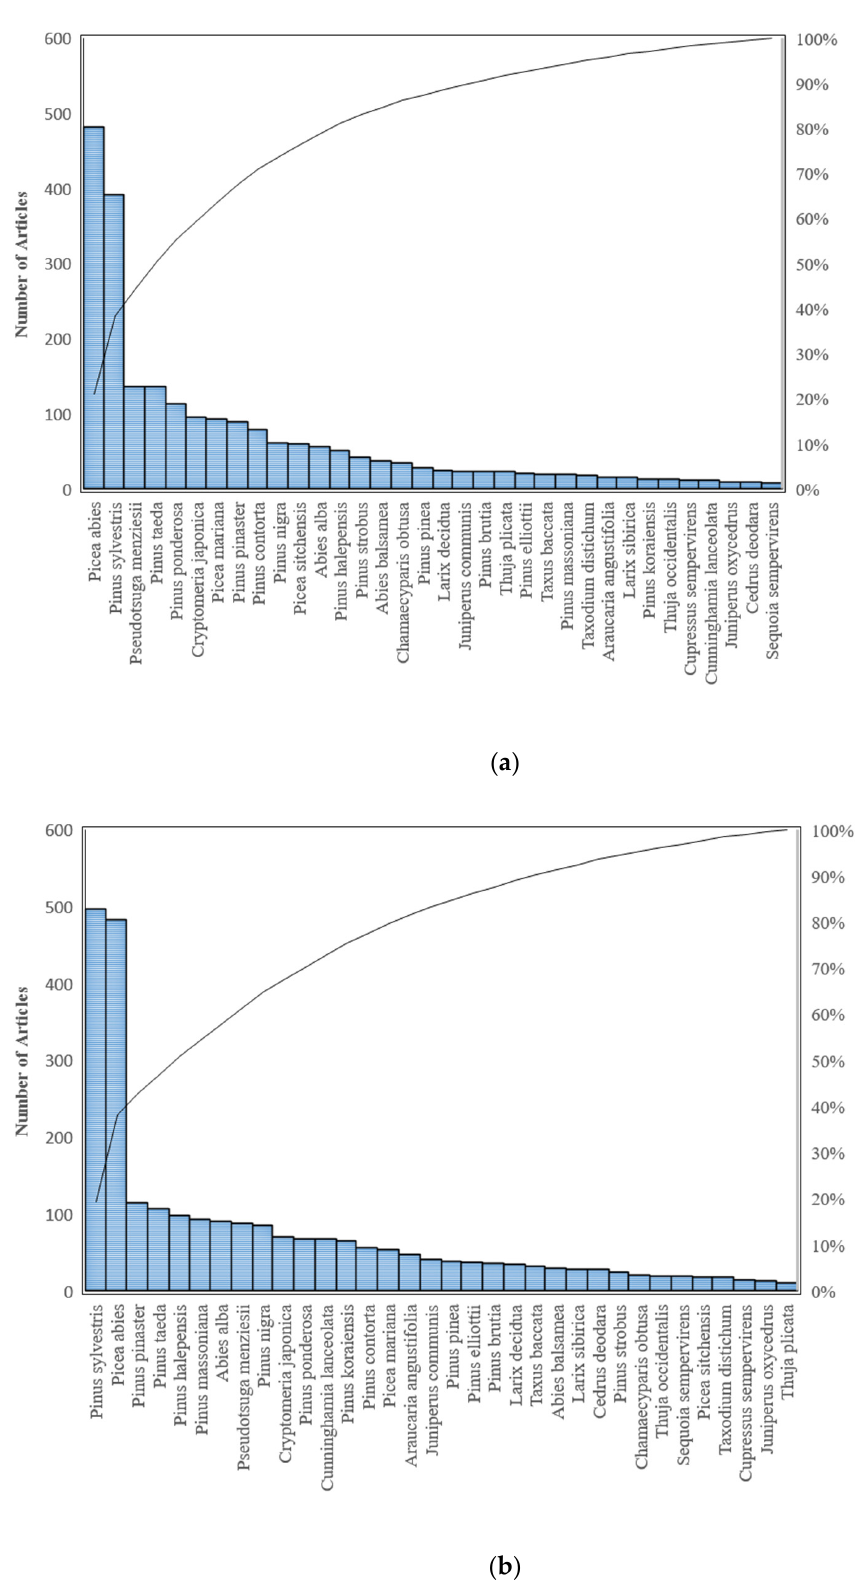
Figure 2. Most studied softwood tree species in 2006 ( a ) and in 2020 ( b ) shown as a Pareto chart, based on Web of Science data.